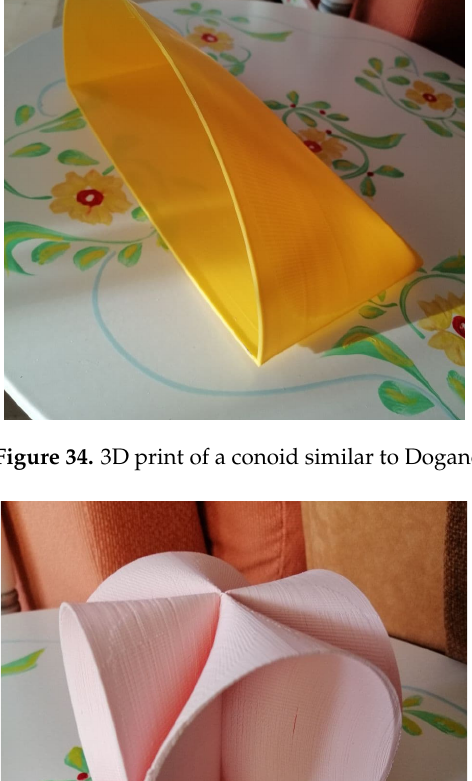
Figure 36. The Dyosphera standing on one of its four bases. We believe that the implications of this geometrical advance are far ‐ reaching. Due to its internal logic, it would be suitable for biotechnology. Especially the last development, the Pterasphera , being of a tubular nature, would be prone to fluid transportation. As a spring ‐ like configuration it conjoins flexibility and balance. In Figures 37 and 38, we pre ‐ sent examples of possible association and growth in parallel or opposed patterns. Figure 37. Two parallel Pterasphera tubules.